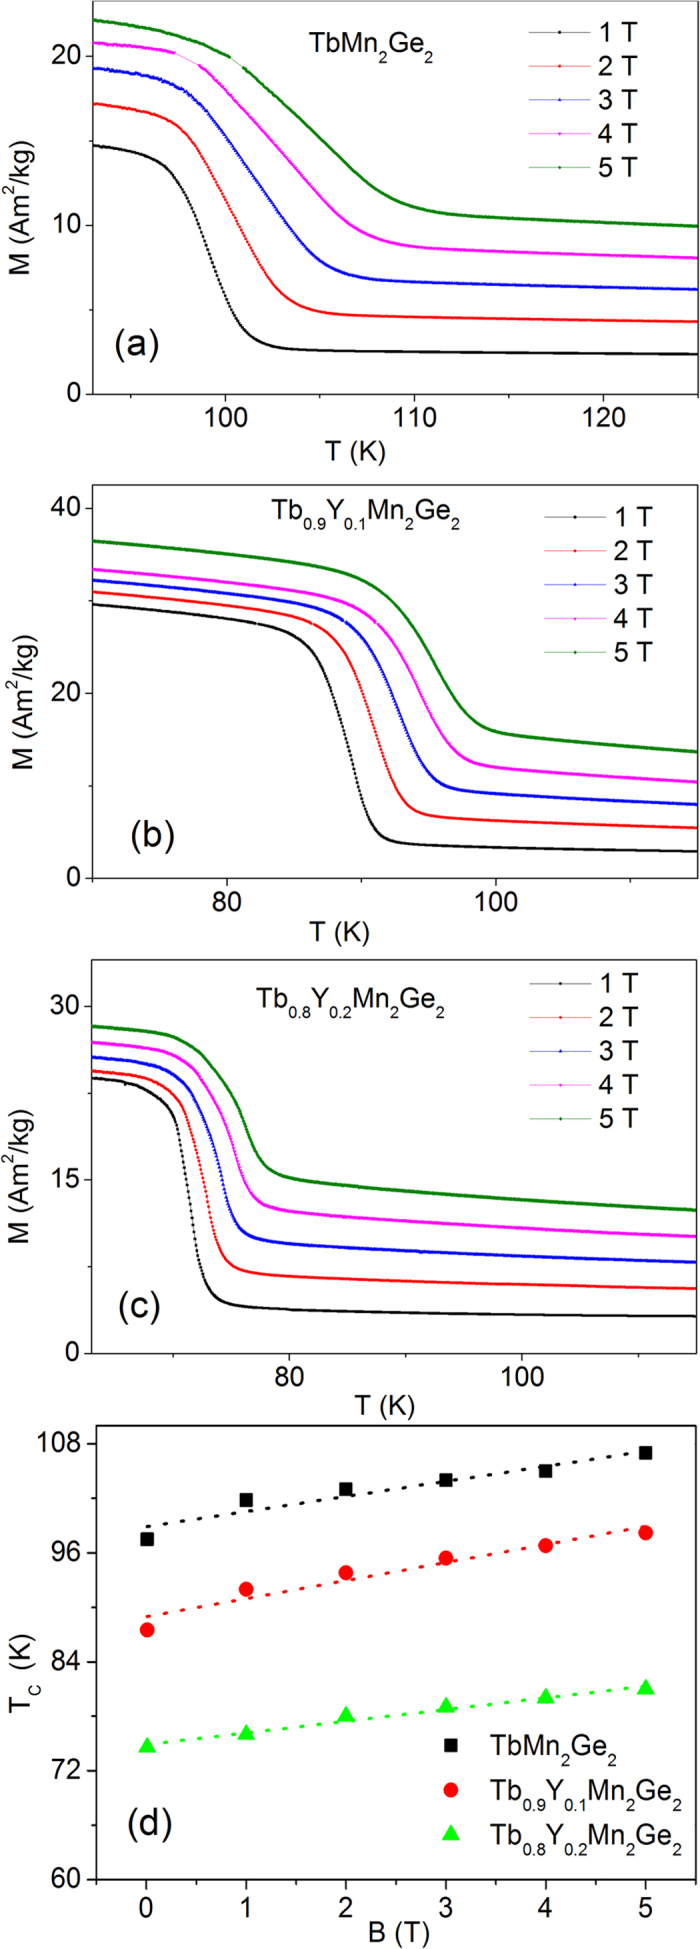
The magnetisation versus temperature curves during cooling under various magnetic field (B = 1–5 T).(a) TbMn2Ge2, (b) Tb0.9Y0.1Mn2Ge2, (c) Tb0.8Y0.2Mn2Ge2. (d) The variation of ferromagnetic transition temperature Tc with magnetic field for the three samples. The dashed lines represent linear fits to the Tc-B curves leading to dTc/dB values for each sample.